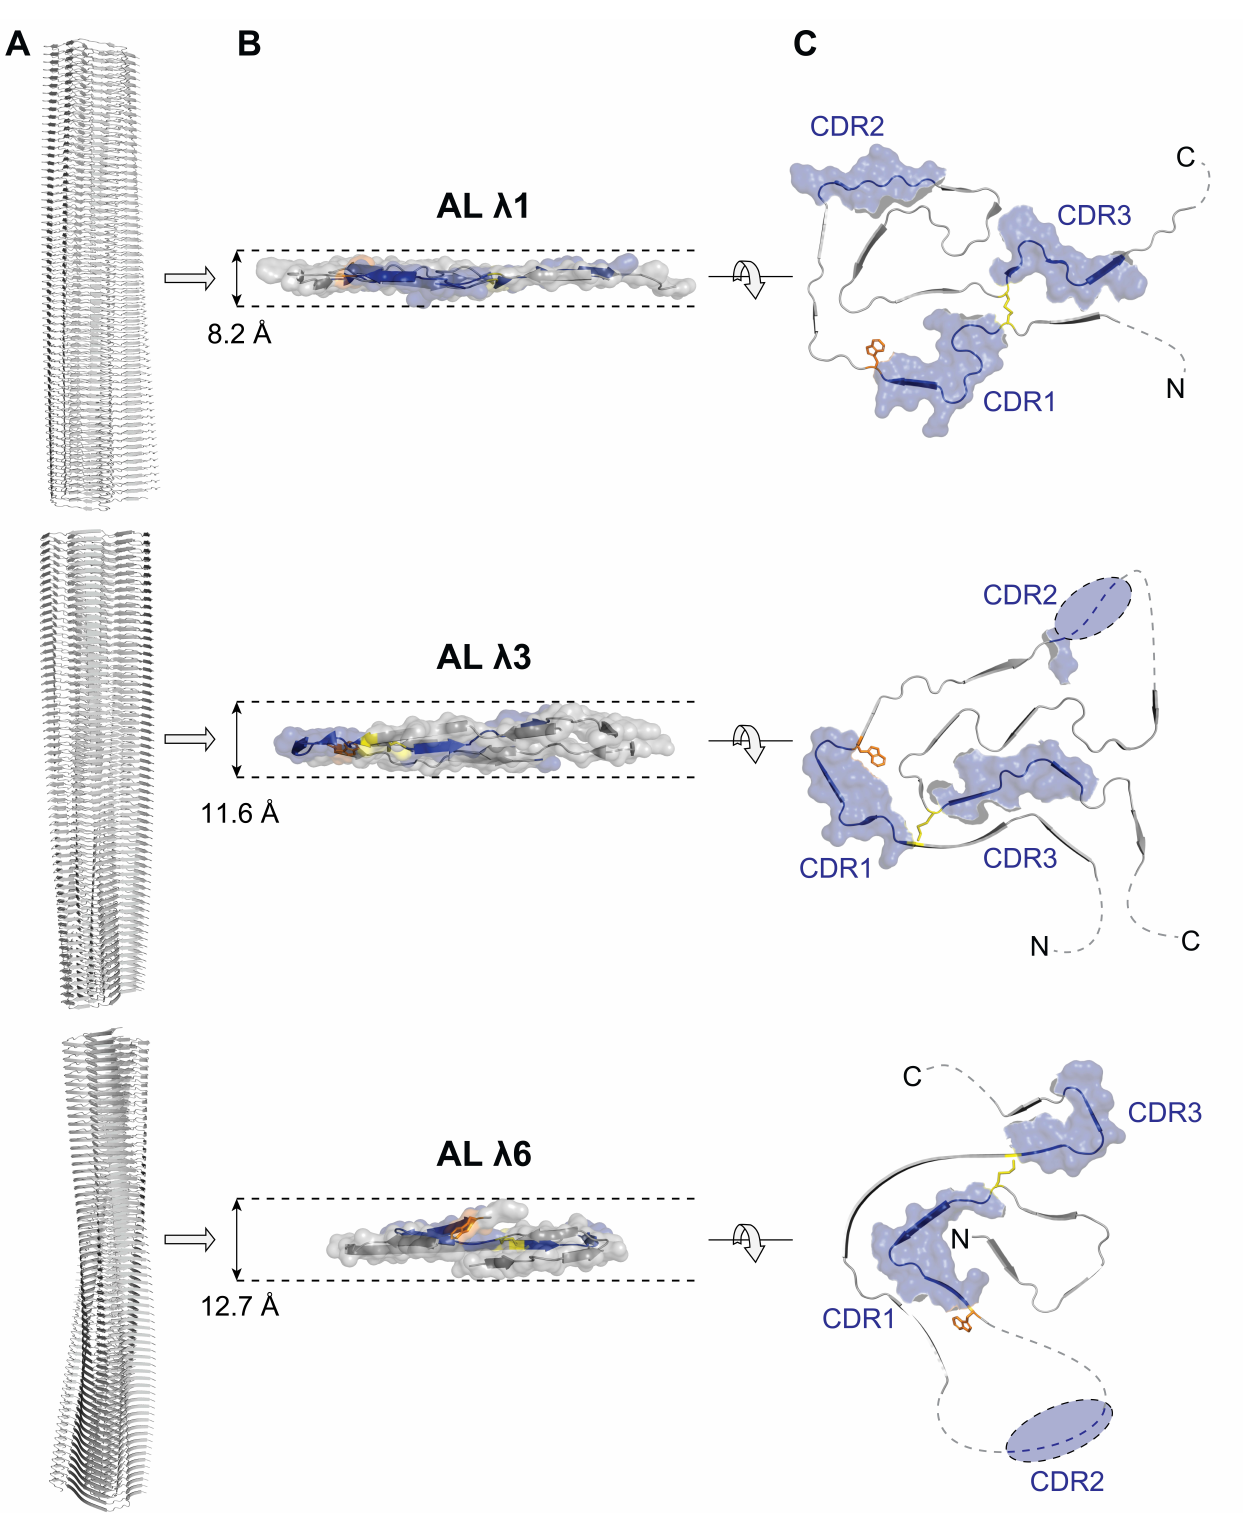
Figure 2. Comparison of the structures of ex vivo AL fibrils. ( A ) Side view of the molecular model of the fibril. Polypeptide chains are shown as ribbon diagram. ( B ) Side view of one monomer layer as a ribbon diagram with surface representation. Numbers represent the height difference of the polypeptide chain. ( C ) Cross-sectional view of the protein conformation. Disordered segments are represented as dotted lines. Blue: CDRs. Yellow: canonical disulfide bridge. Orange: conserved tryptophan. AL λ 1 (PDB entry: 6IC3), AL λ 3 (PDB entry: 6Z1O), AL λ 6 (PDB entry: 6HUD). N: amino terminus, C: carboxy